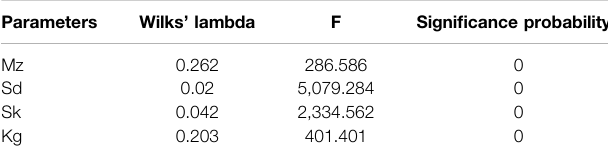
TABLE 2 | Equality test of group means.